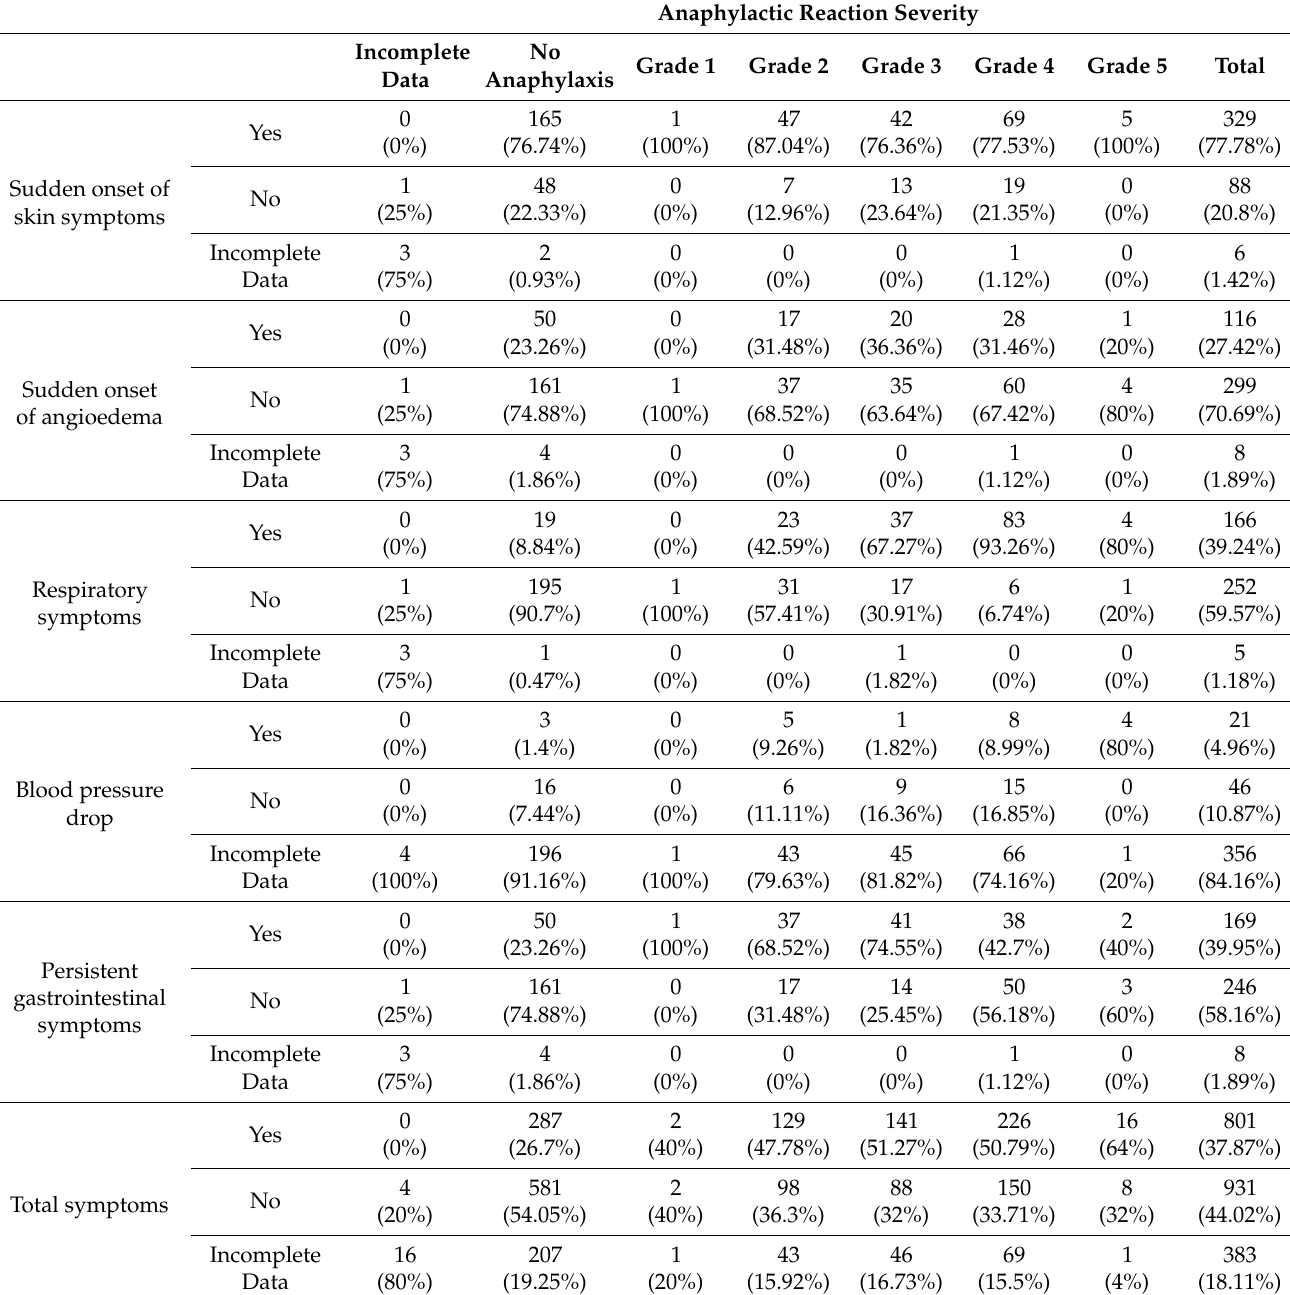
Table 1. Recording of symptoms per system in accordance with the reaction’s